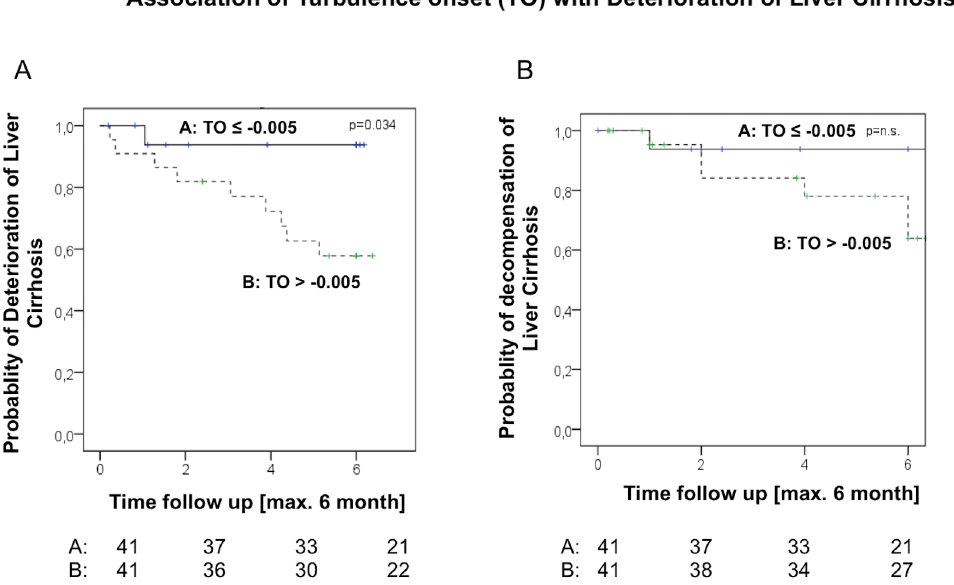
Fig 2. Deterioration of hepatic disease (A) and the decompensation episodes (B) during follow-up stratified using the median of TO-values. Rates are shown using Kaplan-Meier plots and analysed by log-rank